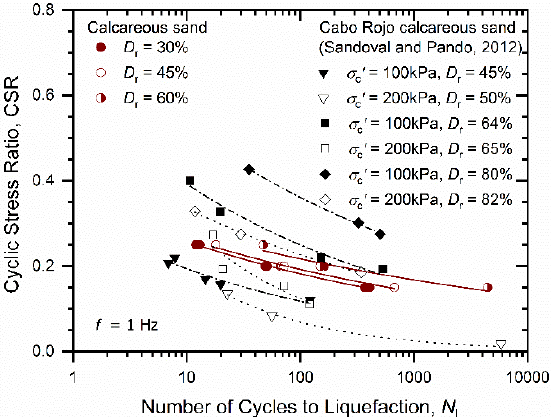
Figure 11. Comparison between the calcareous sand and Cabo Rojo calcareous sand.